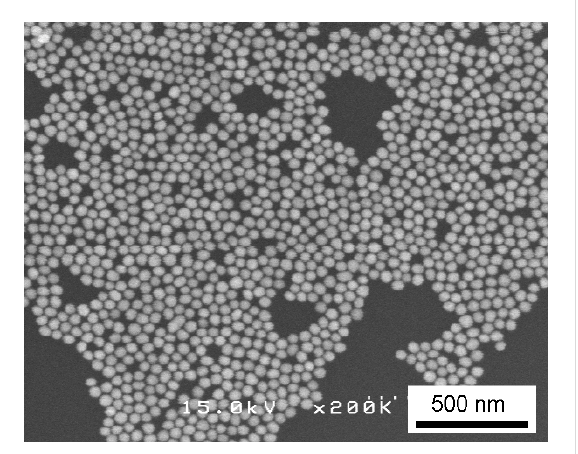
Figure 2: SEM image of the substrate after step (i) using the amine- epoxy method.